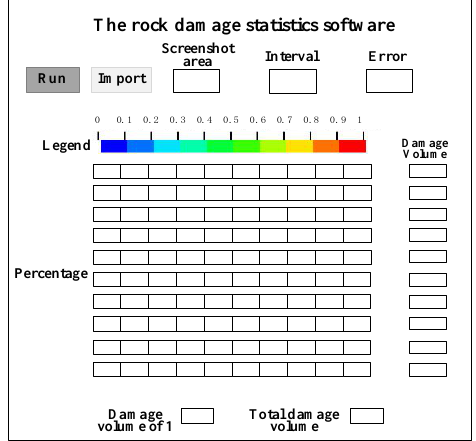
Figure 7. The interface of statistical rock damage software.